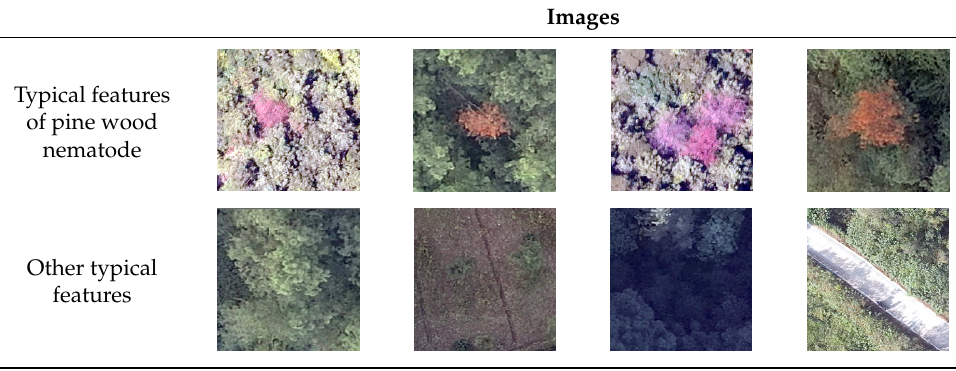
Figure 4. Sample database.